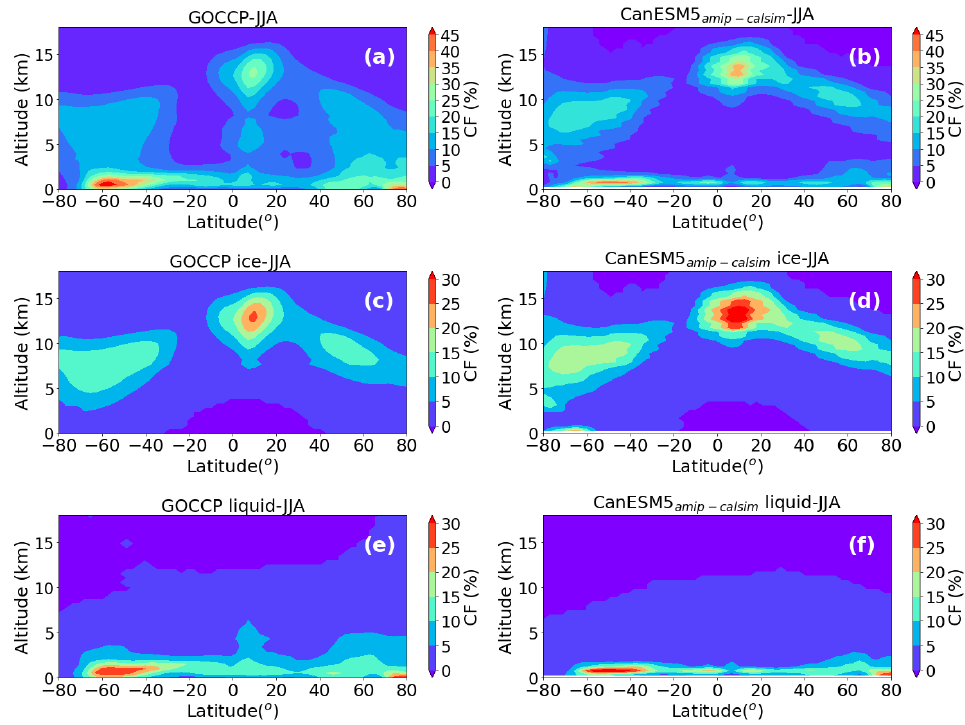
Figure 11. Annually and zonally average vertical cross-section of CF in JJA for GOCCP (TCF ( a ), ice ( c ), and liquid ( e )), and CanESM5 amip−calsim ( b , d , f ).